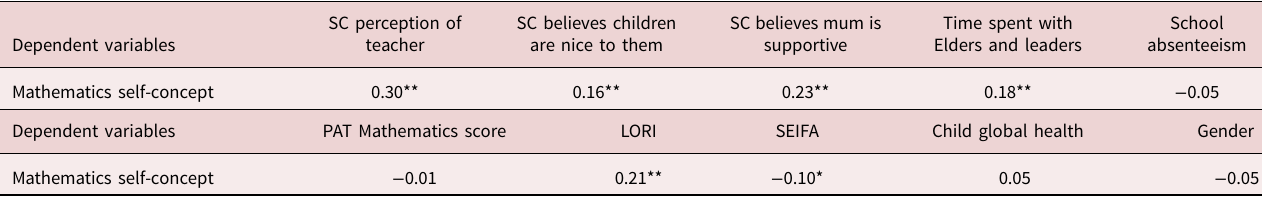
Table 1. Mathematics self-concept ×selected independent variables